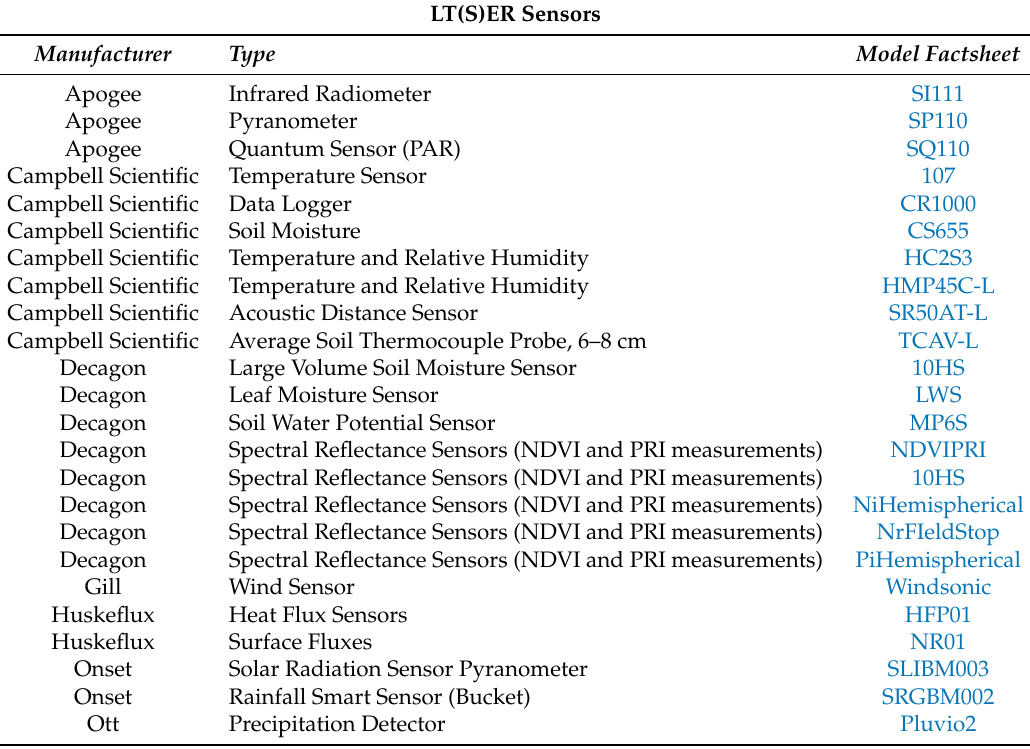
Table 1. List of the main sensors used in the LT(S)ER